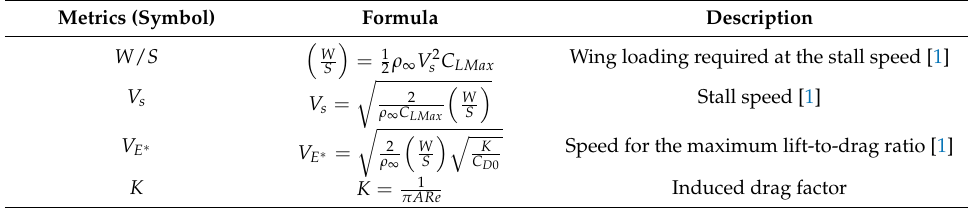
Table 9. Dimensional characteristics of the